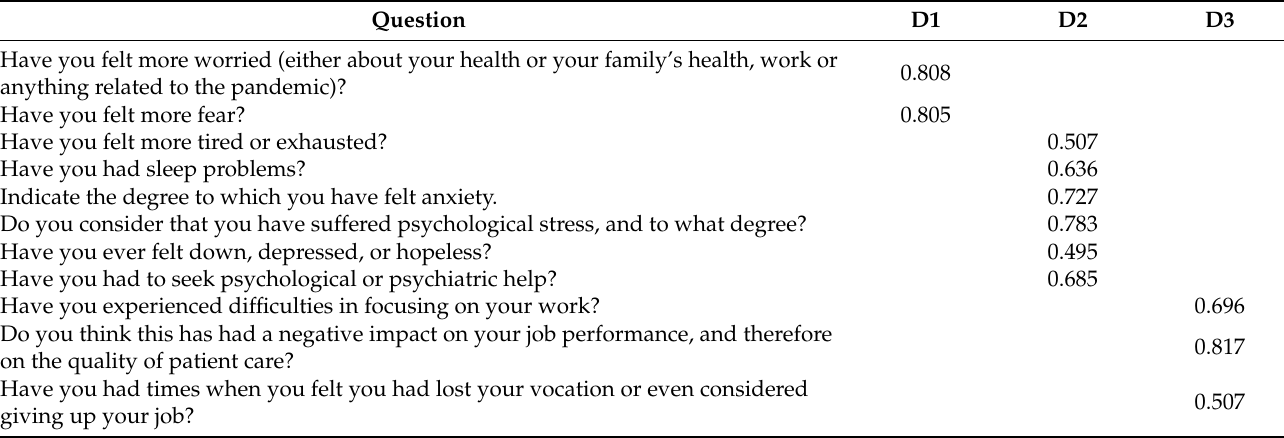
Table 3. Dimensions of the factor analysis of the primary variables.